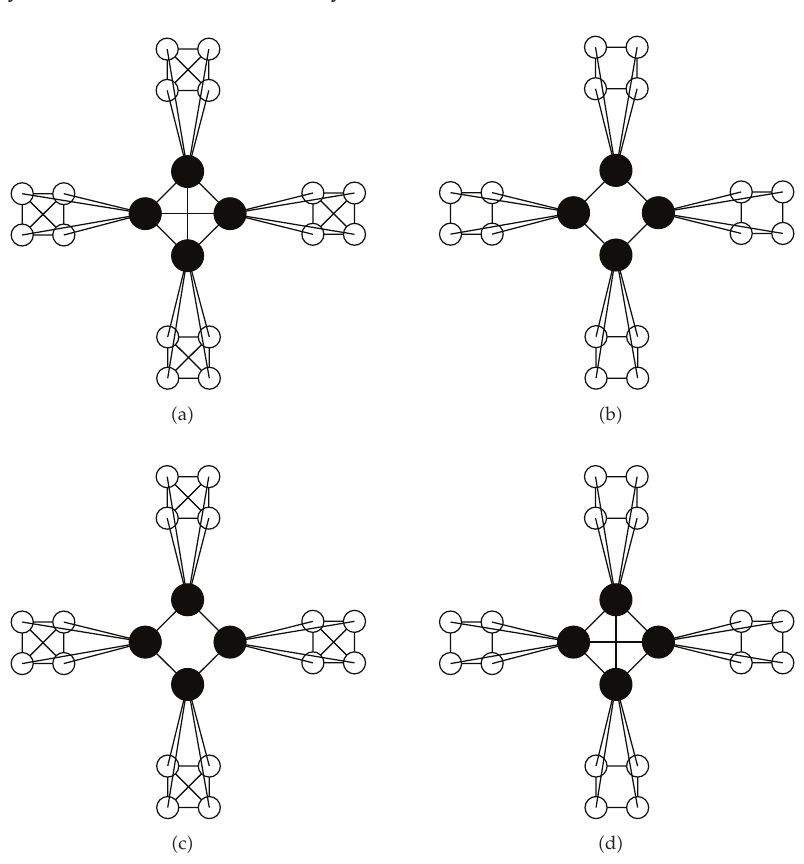
Figure 5: Four hierarchical interaction topologies for PS 2